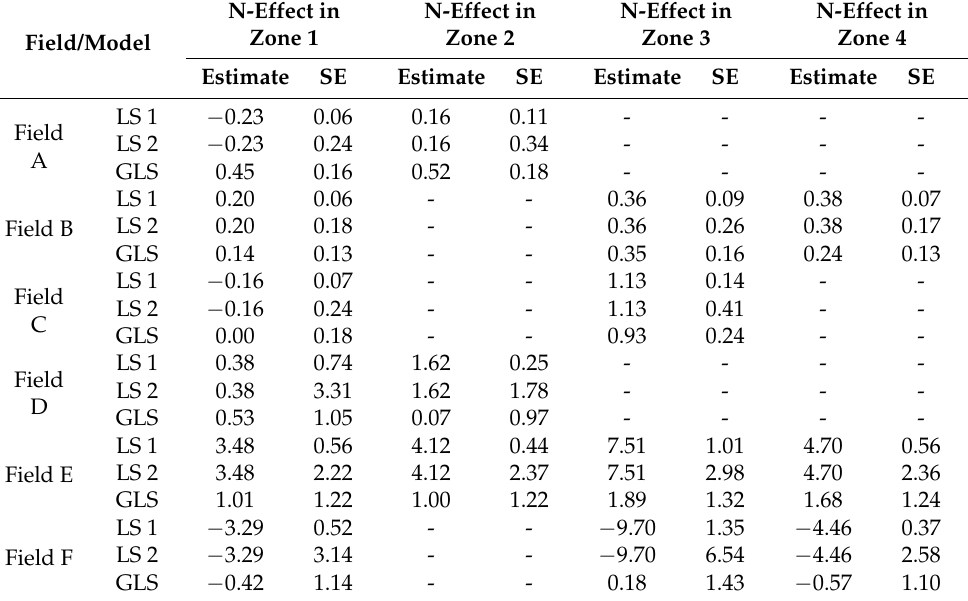
Table 2. A regression model with the yield as the response variable, temporal average yield, latitude, longitude, linear interaction between latitude and longitude, and four corn management zones, delineated as suggested by Kharel et al. [15], and their interaction with N treatment as the explanatory variables (see Equation (7) for the model details) were summarized for six fields (Fields A, B, C, D, E, and F). Each nitrogen effect per management zone was estimated. For LS 1, least squares was used for treatment effects, and independence was assumed for standard errors. For LS 2, least squares was used for treatment effects, and spatial covariance was used for standard errors. For GLS, generalized least squares was used for treatment effects, and spatial covariance was used for standard errors. Fields A, B, and C were harvested for grain. Fields D, E, and F were harvested for